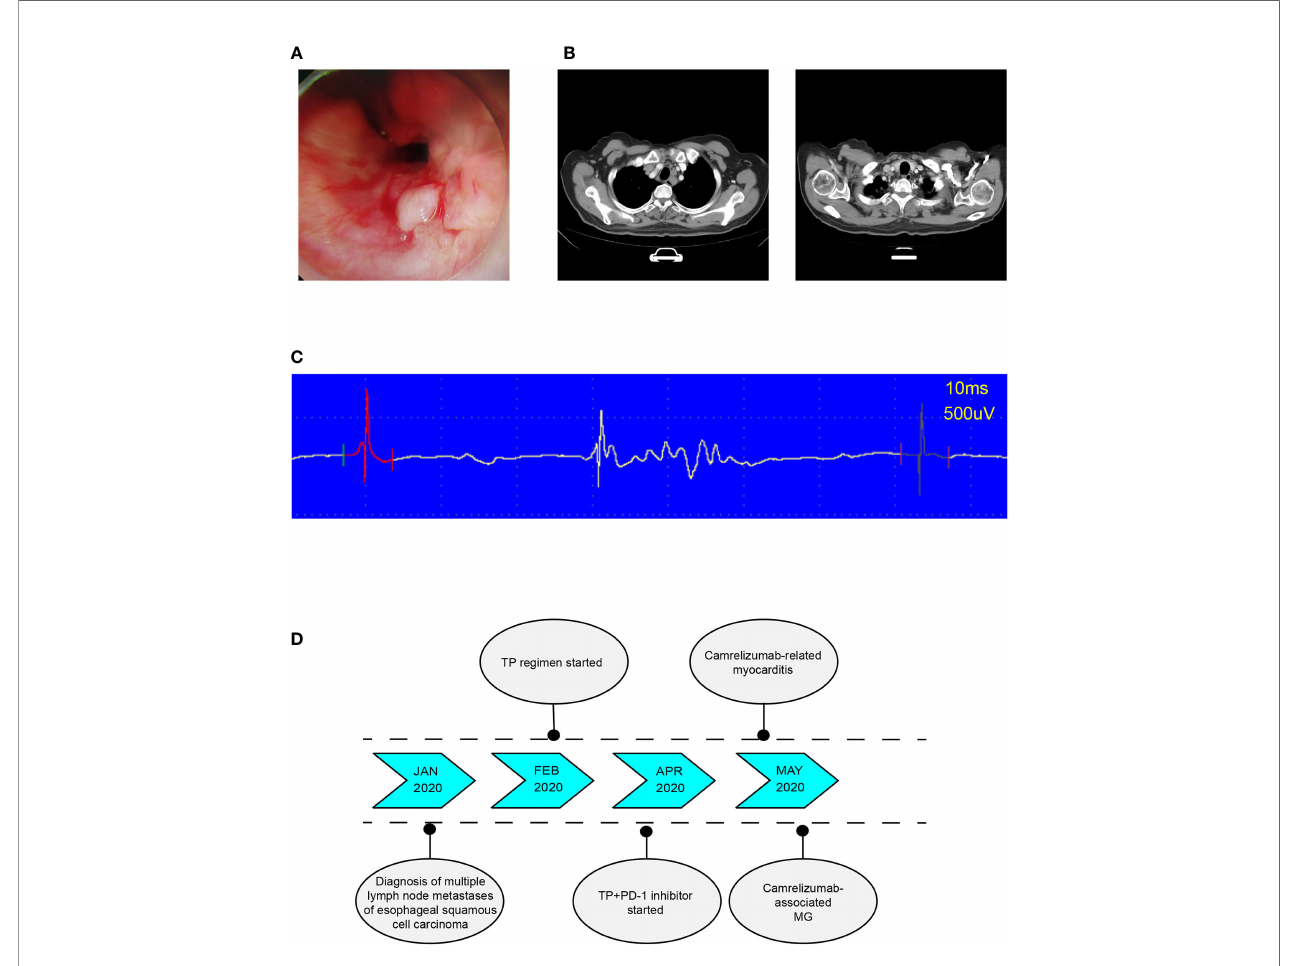
FIGURE 1 | (A) Endoscope images showing an ulcerative neoplasia. (B) In January 2020, posttreatment CT-scan showed middle and upper esophageal carcinoma with bilateral tracheoesophageal sulcus and right supraclavicular lymph node metastasis. (C) Typical electromyogram (EMG) of deltoid muscle showing the patient's myogenic damage. (D) Timeline of diagnosis, treatment, and immune-related adverse